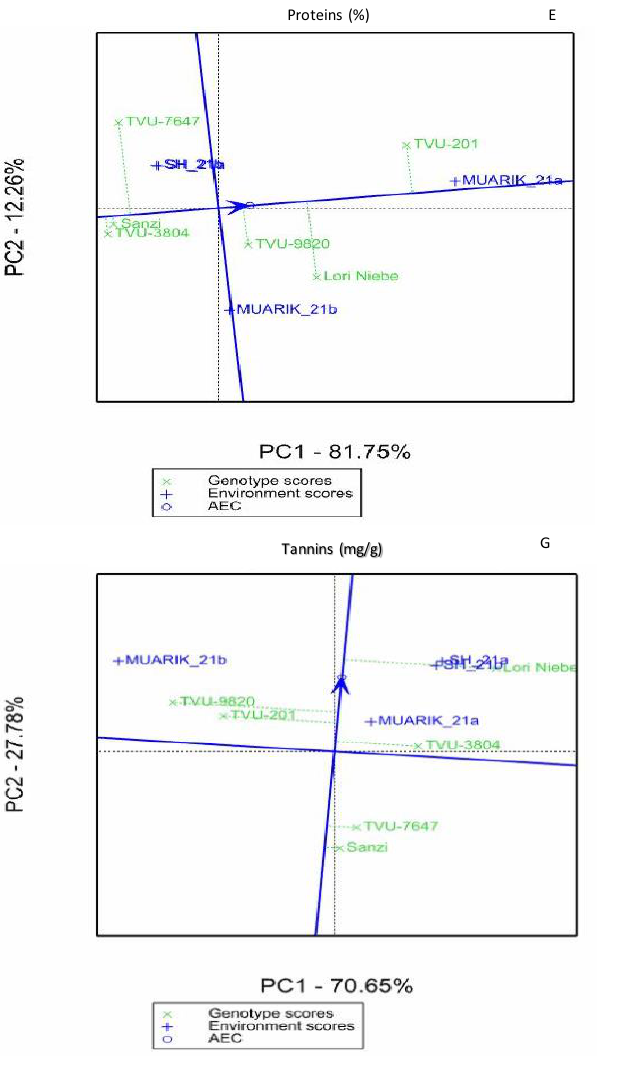
Figure 4. GGE biplot showing the stability of flower thrips damage ( A ), flavonoids ( B ), antioxidants ( C ), phenolics ( D ), proteins ( E ), lignin ( F ), tannins ( G ) and reducing sugars ( H ) in the cowpea genotypes tested in four environments in Uganda.